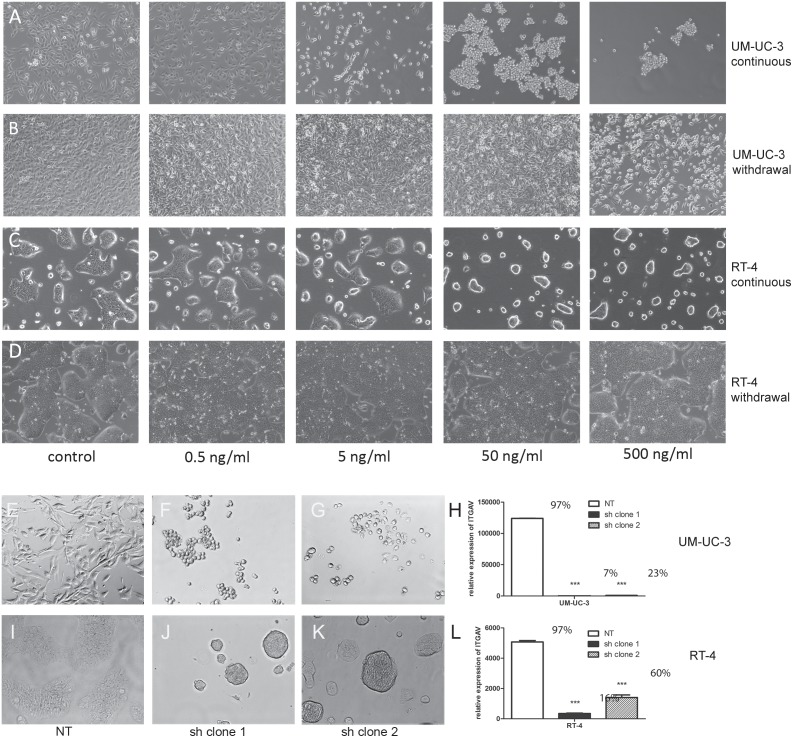
Effects of GLPG0187 and ITGAV knockdown on adherence to tissue culture plastic.Representative images of cells treated for 24 hours with a concentration series of GLPG0187 (dosage between 0–500 ng/ml, indicated underneath the images). Treatment resulted in a dose-dependent loss of adherence to tissue culture plastic in both UM-UC-3luc2 cells (A) and RT-4 cells (C). After 48 hours of GLPG0187 treatment, cells cultured for 4 days in GLPG0187-free medium regained their adherence to the tissue culture plastic in UM-UC-3luc2 cells (B) and RT-4 cells (D). Loss of adherence was also observed in UM-UC-3luc2 and RT4 cells stably transduced with a short hairpin targeted against ITGAV (respectively F–G for UMUC3luc2 sh ITGAV clones 1 and 2 and J–K for RT4 shITGAV clones 1 and 2). As a control, cells stably transduced with a non-targeting short hairpin (NT) were used (UMUC3 (E) and RT4 (I)). Flow cytometric analysis of relative ITGAV expression levels in UM-UC-3luc2 (H) and RT4 (L) cells (% of positive cells * mean fluorescence intensity). Data are presented as mean ± SEM, n = 3, the percentage of ITGAV positive cells is indicated above the bars.